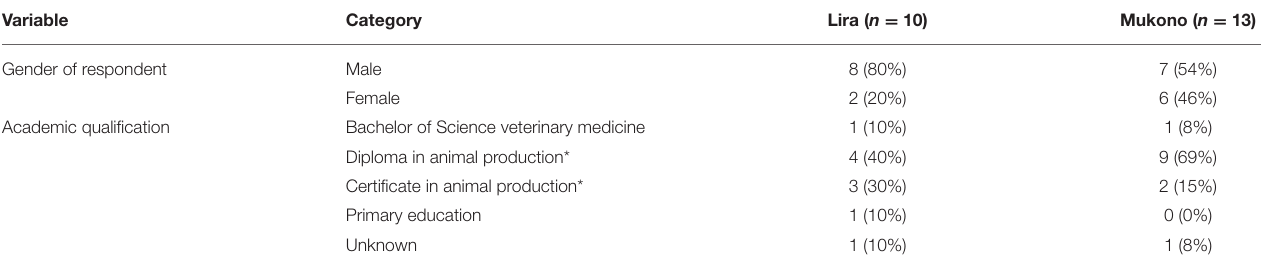
TABLE 2 | Demographic characteristics study participants (drug retailers) by